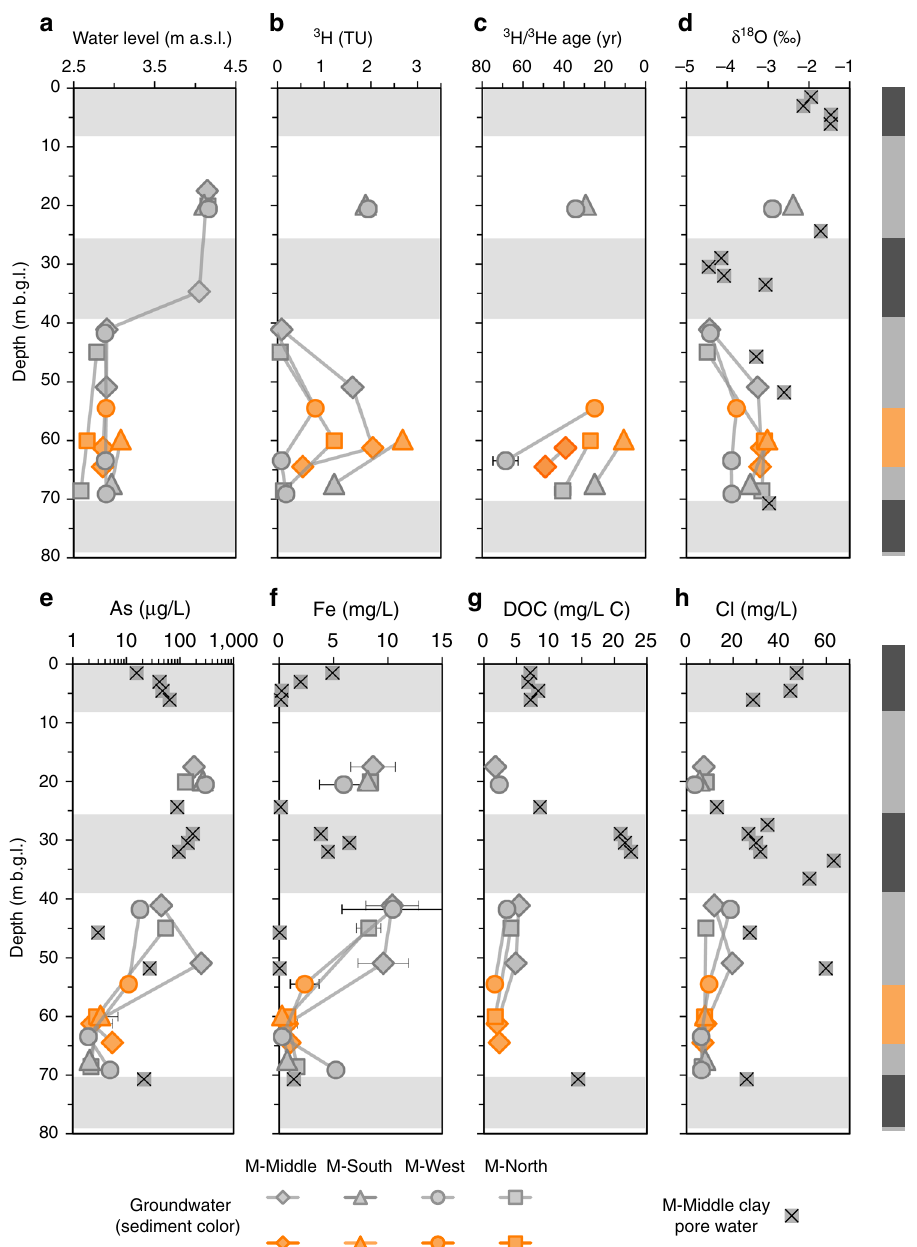
Fig. 3 Vertical pro fi les of groundwater and clay pore water properties. A generic site litholog is displayed on the right with shading in the panels indicating the extent of major clay/silt layers encountered. a Water levels are the annual average (December 2012 – November 2013) groundwater elevations in meters above sea level. b Tritium ( 3 H) concentrations and d Oxygen-18 isotopic composition in water ( δ 18 O) are one-time measurements with analytical error bars smaller than the symbol size. c Tritium-helium ( 3 H/ 3 He) ages were corrected for radiogenic He contribution and degassing at the time of sampling, where necessary; error bars indicate propagated analytical errors or standard deviations of the ages determined under different assumptions, whichever error is greater. e Arsenic, f iron, and h chloride concentrations in groundwater were averaged from discrete samples collected in 2011 – 2012 (arsenic data through 2016/17 from well nest M-Middle are shown in Fig. 1b); at depths where >3 samples were measured, standard deviations are also shown (As and Fe); Cl standard deviations are smaller than the symbol size. g Dissolved organic carbon